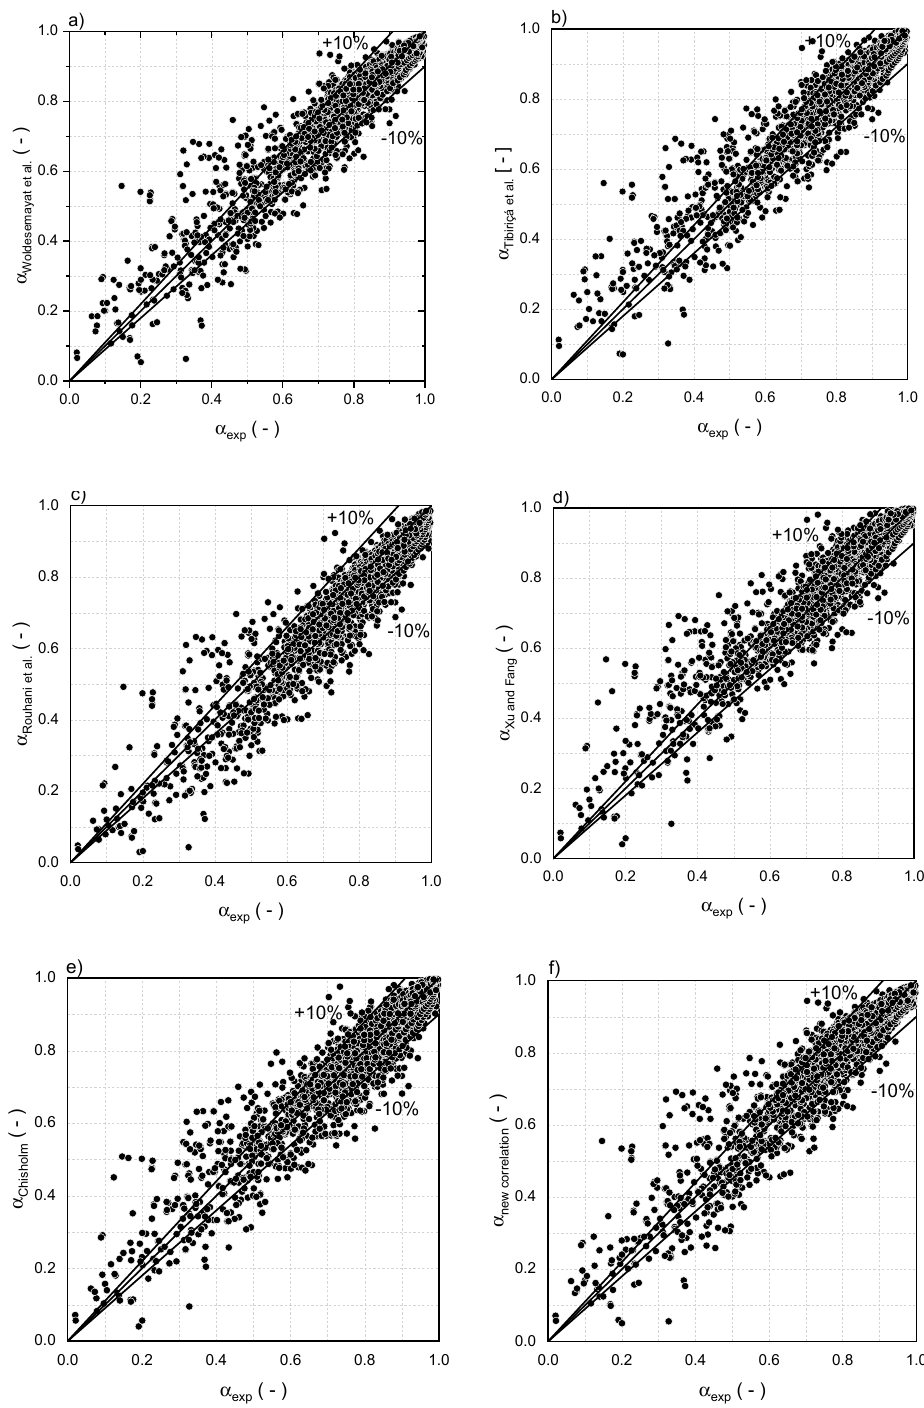
Figure 8. Comparison between the void fraction experimental data and the predicted data of ( a ) Woldesemayat et al. [5], ( b ) Tibiriçá et al. [2], ( c ) Rouhani and Axelsson. [68], ( d ) Xu and Fang [8], ( e ) Chisholm [71], and ( f ) new correlation.